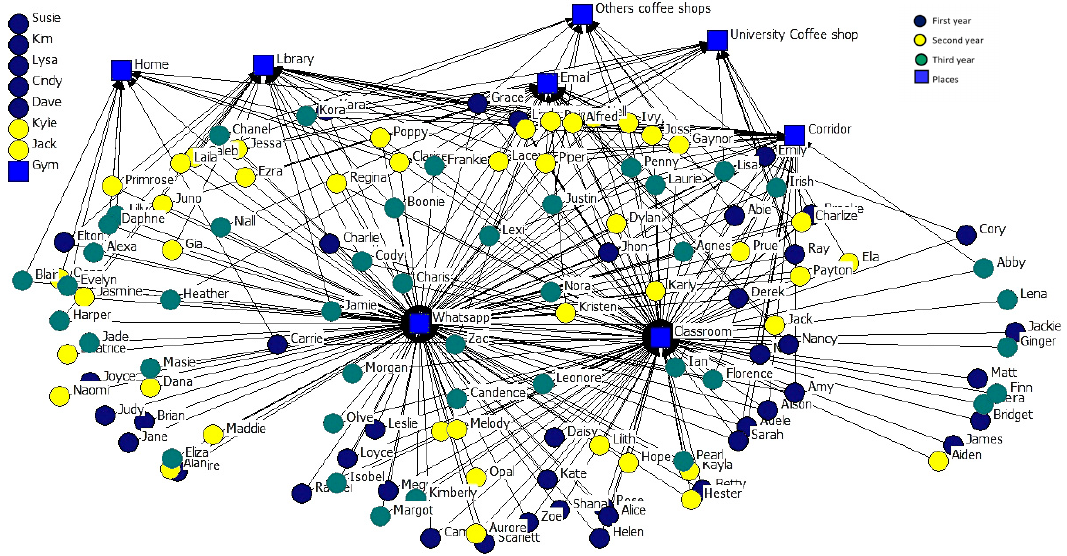
Figure 14. 2 ‐ mode Network of places where academic information is shared.